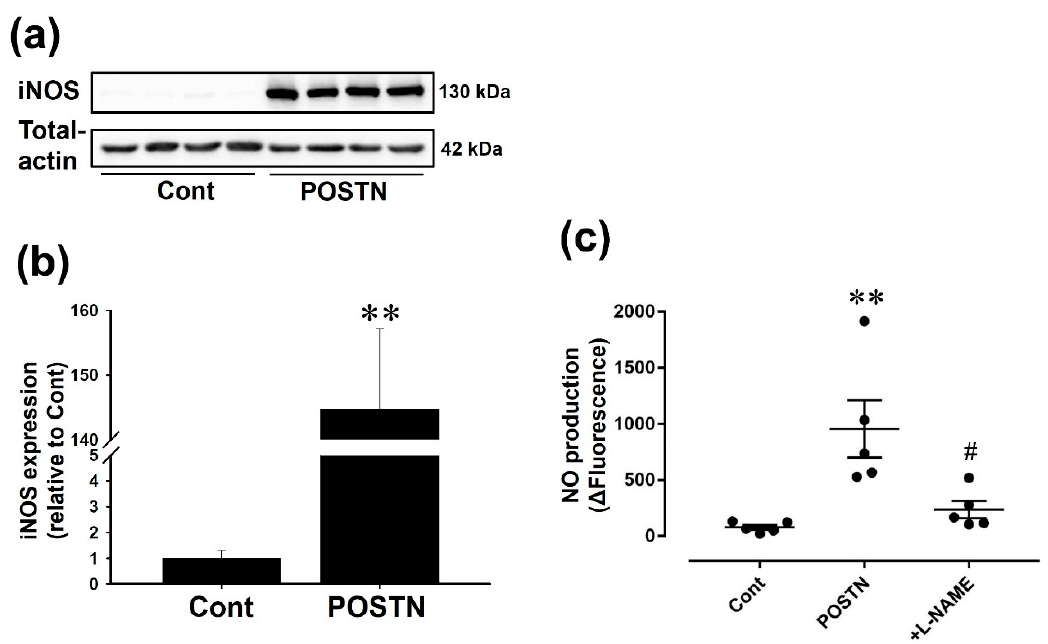
Figure 4. Recombinant rat POSTN enhanced iNOS protein expression and NO production in RVFbs. RVFbs were stimulated with recombinant rat POSTN (1000 ng/mL) or solvent (Cont) for 24 h. iNOS expression in RVFbs was evaluated by western blotting. ( a ) Representative blots were shown. ( b ) Expression level of iNOS was corrected by total-actin, and the normalized expression relative to Cont was shown as mean ± S.E.M. ( n = 4). NO production was measured by using an NO-specific fluorescent dye 4,5-diamino-fluorescein (DAF-2). ( c ) The fluorescence at 120 min after treatment with L -arginine in the presence (+ L -NAME) or absence of pretreatment with N ( ω )-nitro- L -arginine methyl ester ( L -NAME, 600 µ M, 10 min), was subtracted by the fluorescence at 0 min ( ∆ Fluorescence), and shown as mean ± S.E.M. ( n = 5). ** p < 0.01 versus Cont, # p < 0.05 versus POSTN.